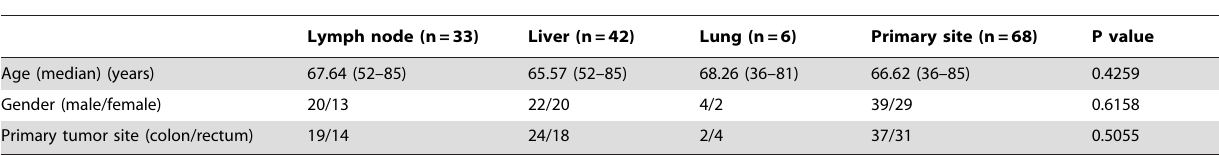
Table 1. Characteristics of patients with metastatic colorectal cancer.